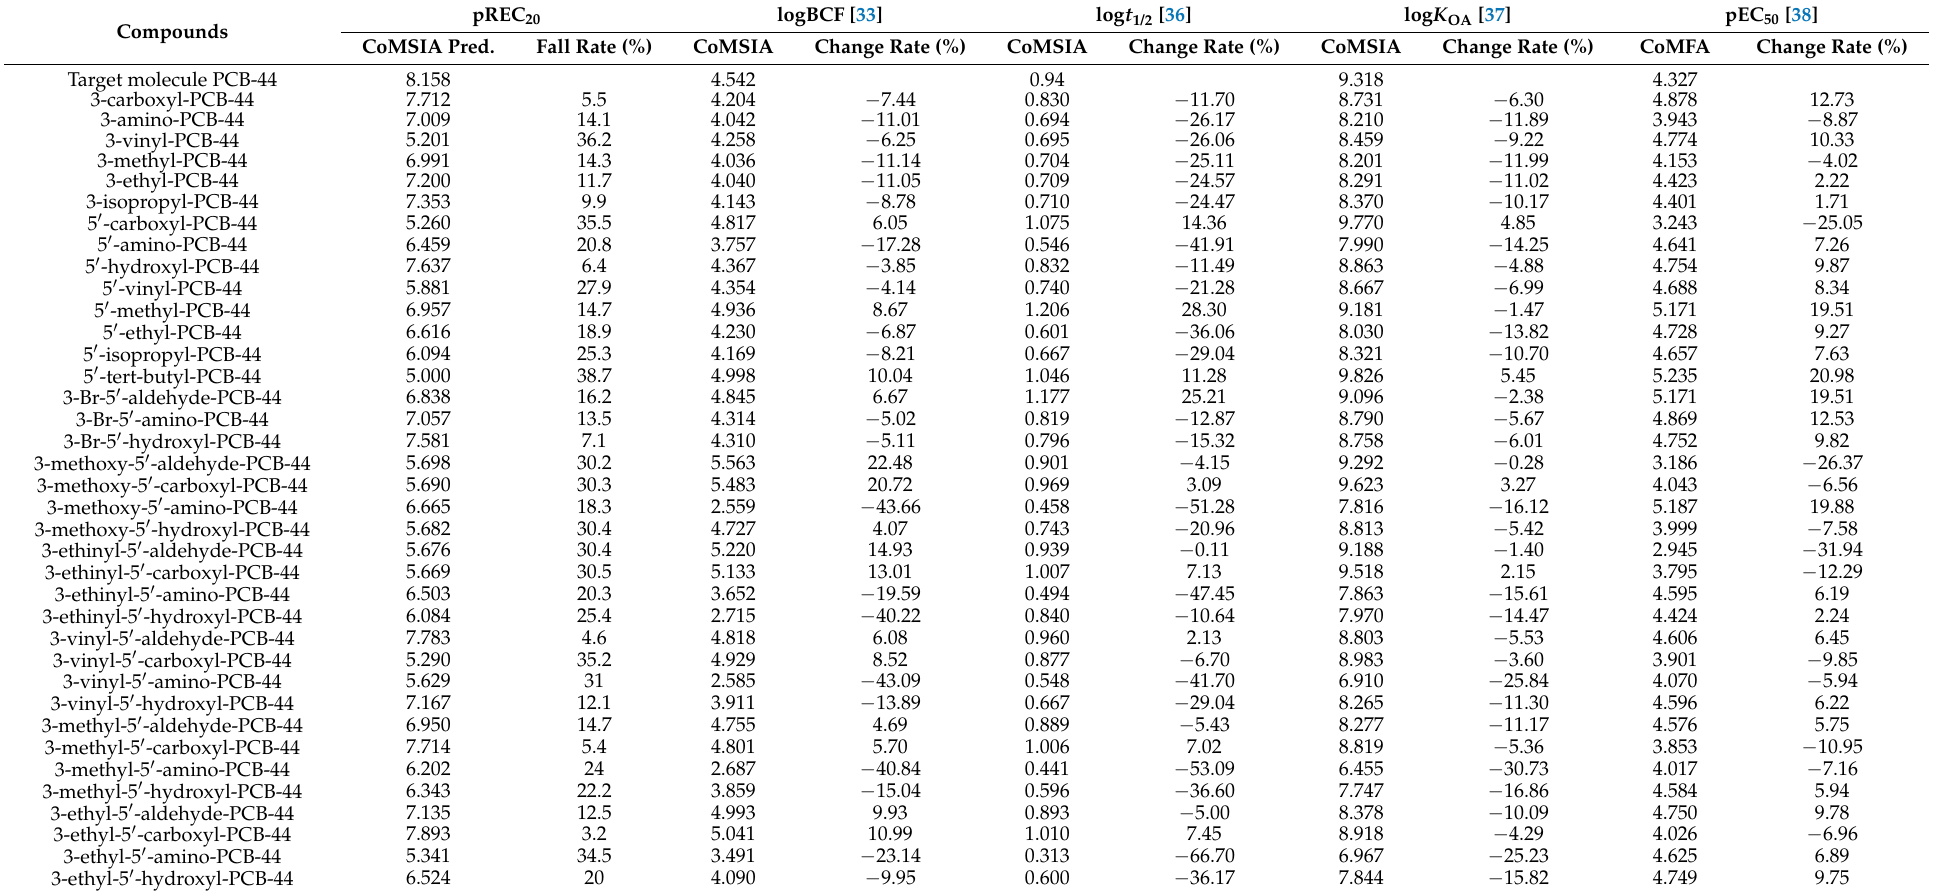
Table 3. Predicted anti-oestrogenic activity, bio-concentration, environmental persistence, long-distance migration, and biological toxicity of the novel PCB-44 molecules. Compounds Target molecule